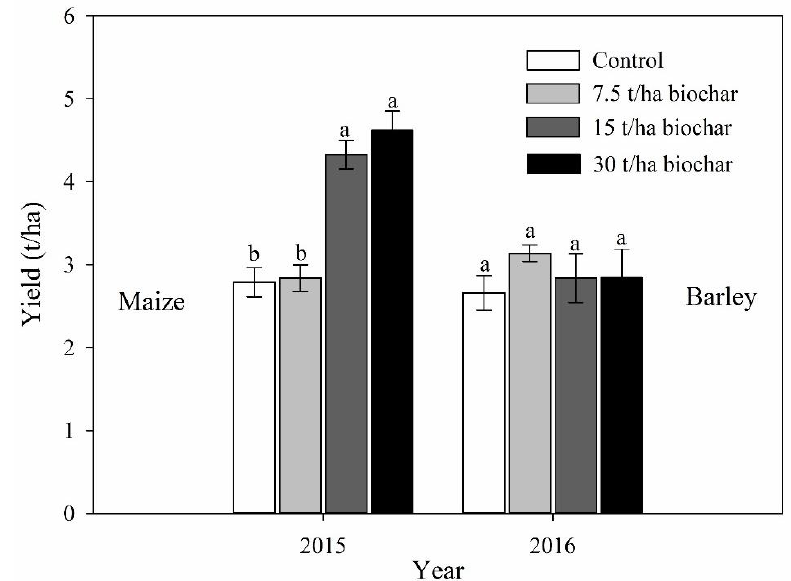
Figure 5. Crop yields of maize and barley as affected by biochar (BC) treatment. Values are means ± SD ( n = 3). Bars with different letters in each year are significantly different according to LSD at p < 0.05.